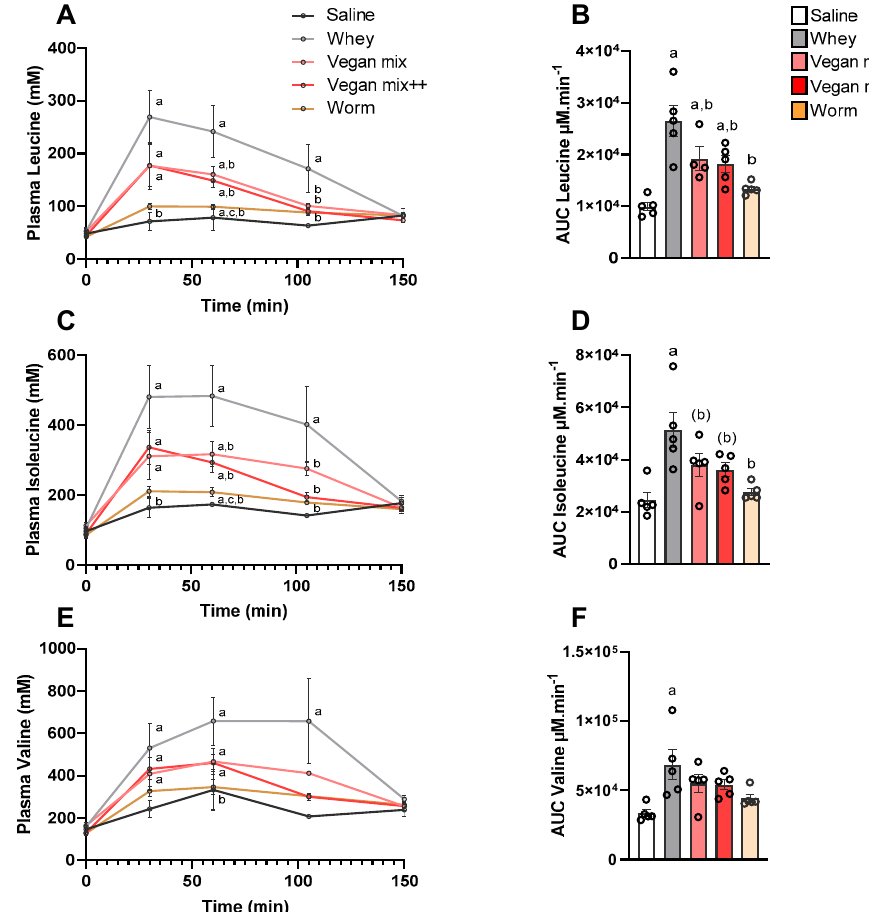
Figure 2. Increase in plasma BCAA upon gavage of different AA mixtures. ( A ) Plasma leucine. ( B ) Leucine area under the curve (AUC). ( C ) Plasma isoleucine. ( D ) Isoleucine AUC. ( E ) Plasma Valine. ( F ) Valine AUC. Data is presented as mean ± SEM, n = 5. a p < 0.05 vs. saline, b p < 0.05 vs. whey, (b) p < 0.10 vs. whey. Vegan mix ++ annotates the leucine-matched (to whey) vegan mix.